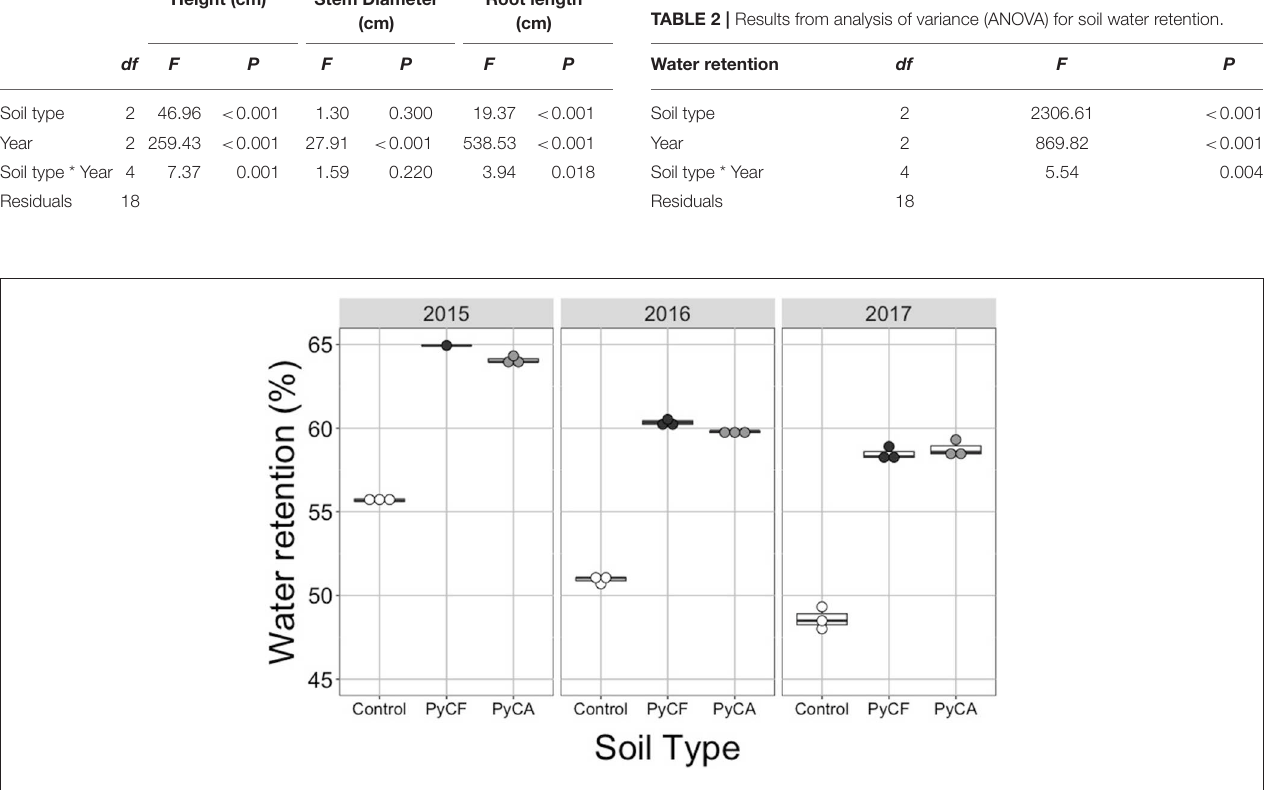
FIGURE 3 | Dot and box plots of soil moisture retention for soil-less media controls (white dots) and media amended with forest (PyCF; dark gray dots) and recycled feedstock (PyCA; light gray dots) pyrogenic carbon in 2015, 2016, and 2017. Statistical results can be found in Table 2 .